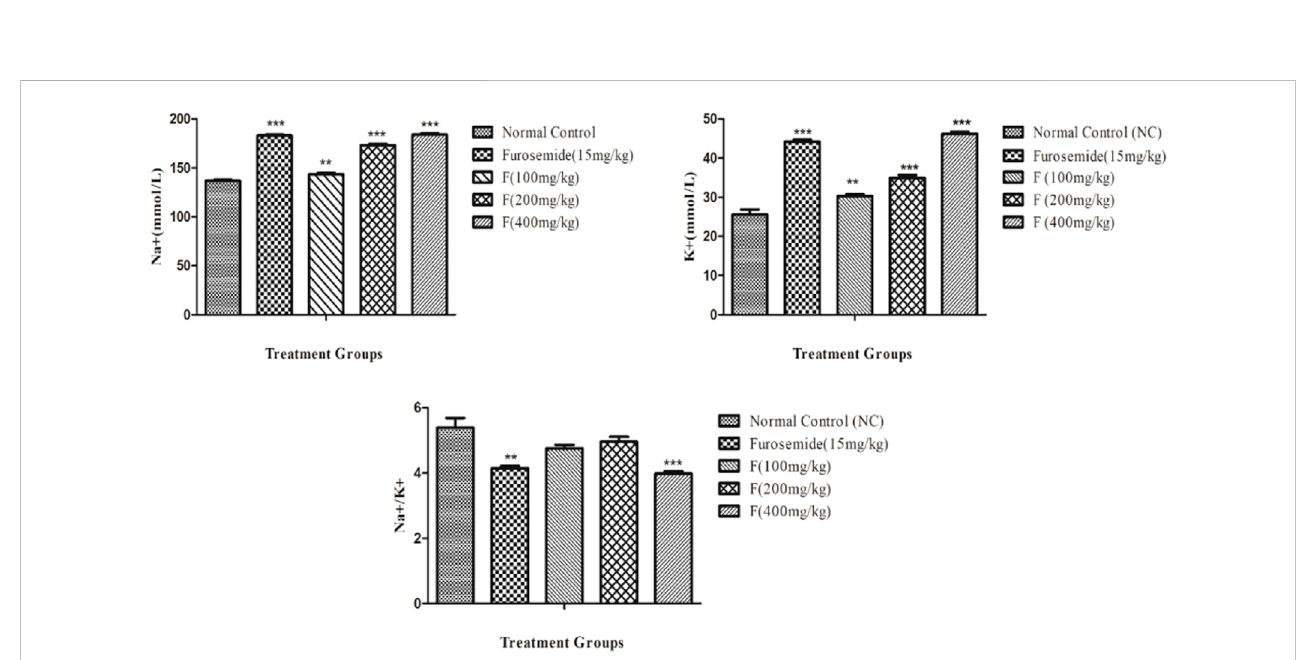
FIGURE 3 Effect of different doses of fenchone on urinary electrolytes (Na + and K + ) where furosemide was taken as the standard drug. Data are stated as mean ± SEM, N = 6. *** p < .001 represents a signi fi cant increase, while ’’’ p < .001 represents a signi fi cant decrease vs. normal control.